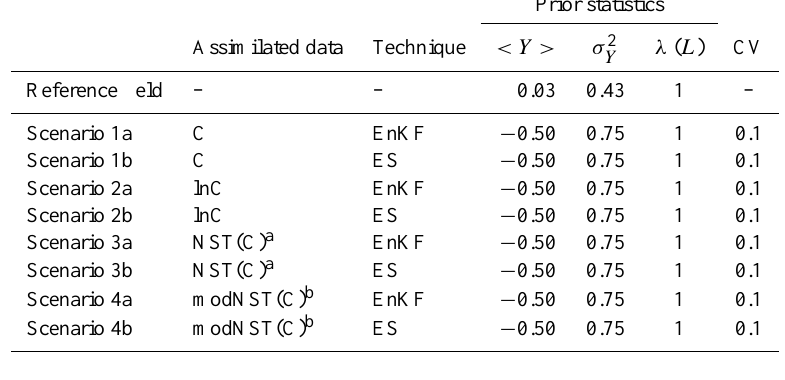
Table 1. Description, prior geostatistical parameters, and measurement errors of the numerical experiments. CV stays for the measurement coefficient of variation. In scenarios labeled with “a”, the normal score transform is applied independently to the ensemble of concentration data in each assimilation node. In scenarios labeled with “b ”, the normal score transform is applied to the ensemble of concentration data over all assimilation nodes.